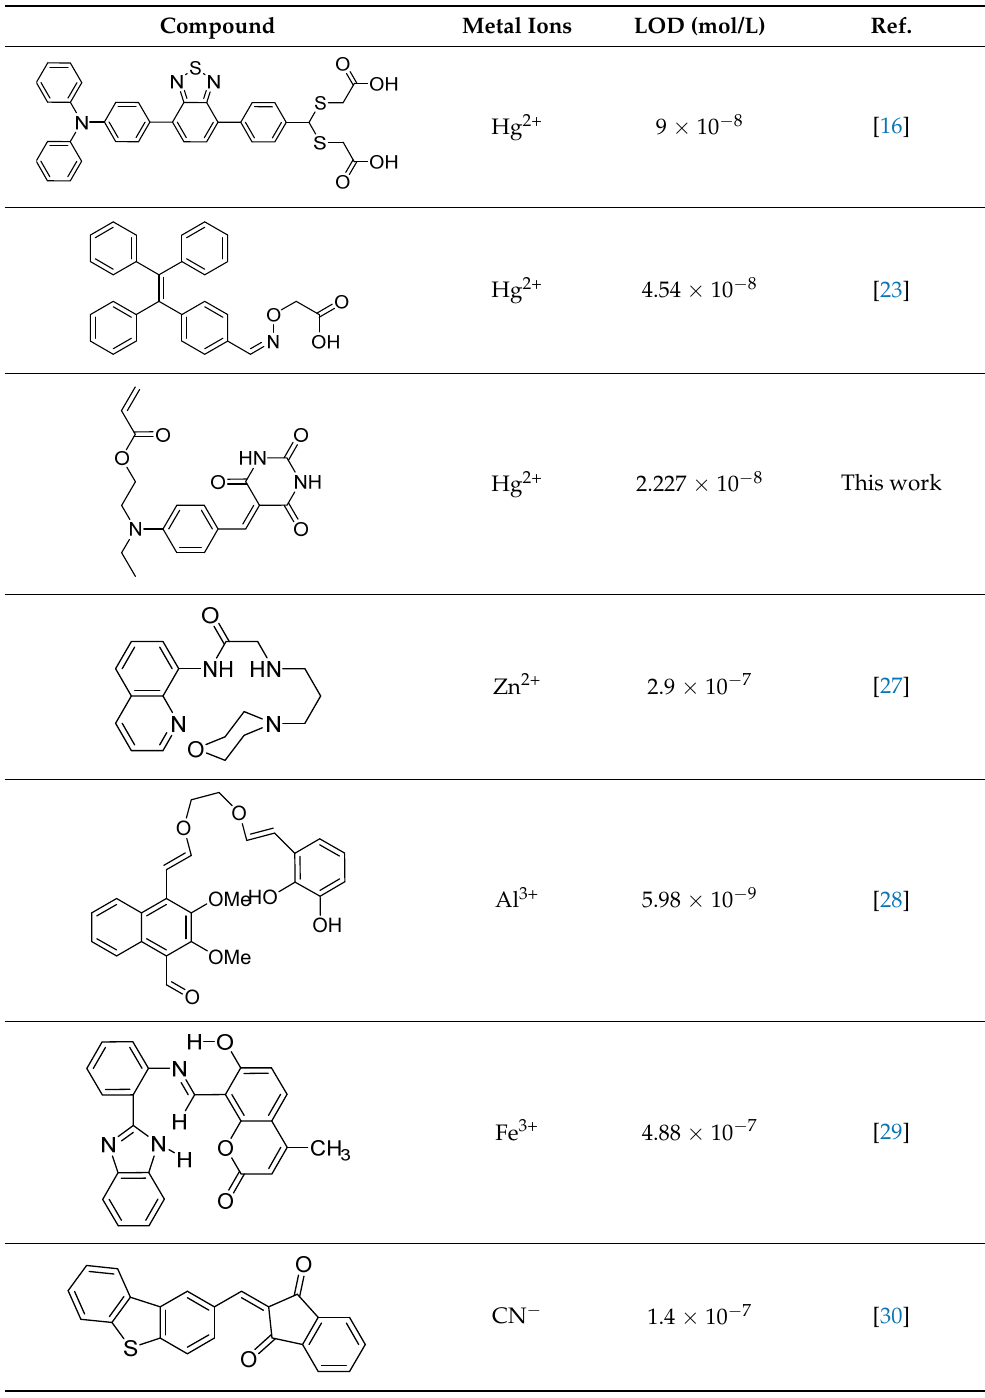
Table 1. Comparison of the probe BNEA with previously reported probes. Compound